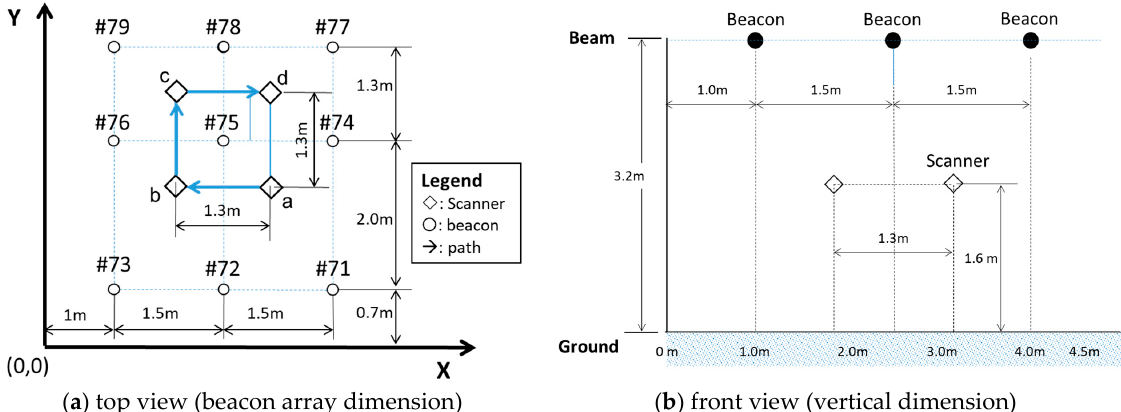
Figure 9. Beacon configuration and scanner path.